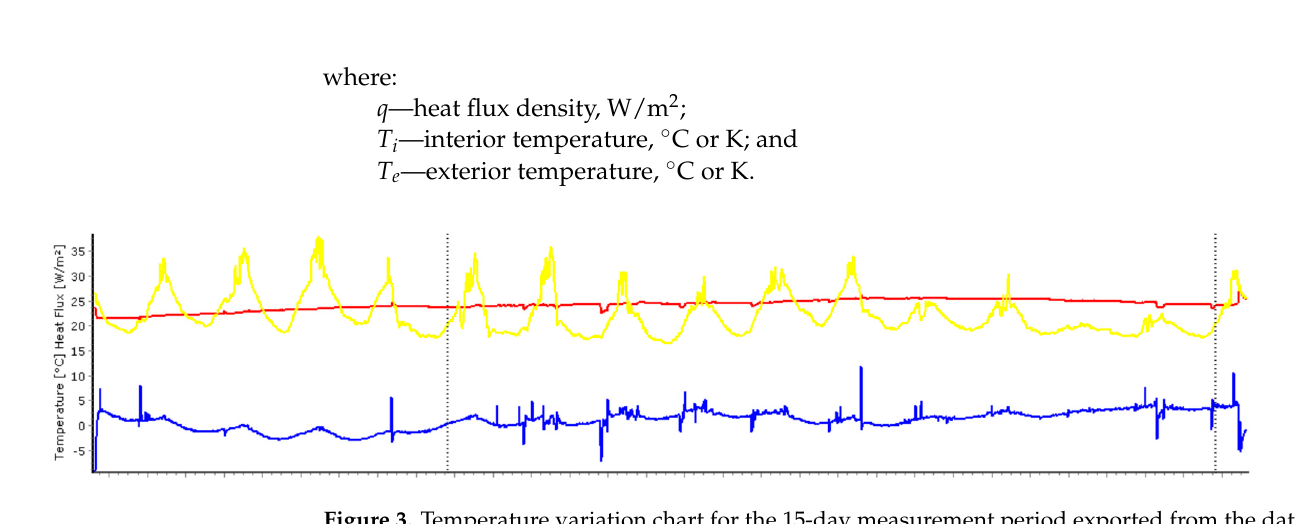
Table 2. Average nigh value of the thermal transmittance for the exterior wall.